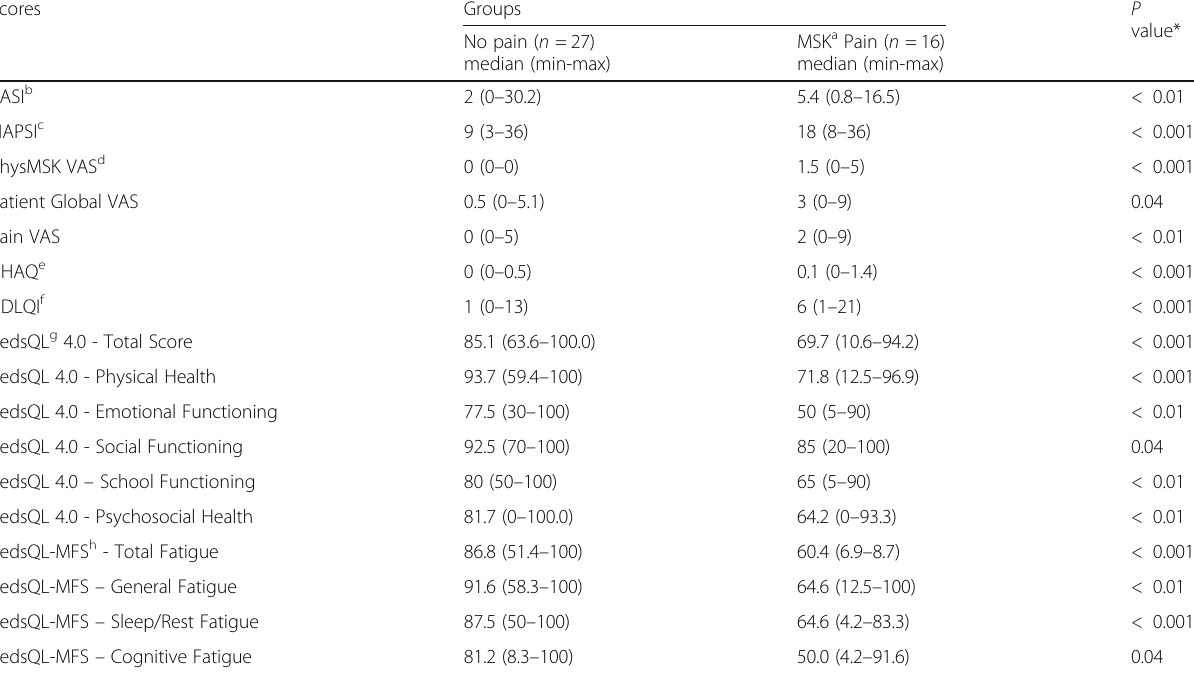
Table 2 Psoriasis scores, physician ’ s score, patient-reported outcomes among participants with or without musculoskeletal